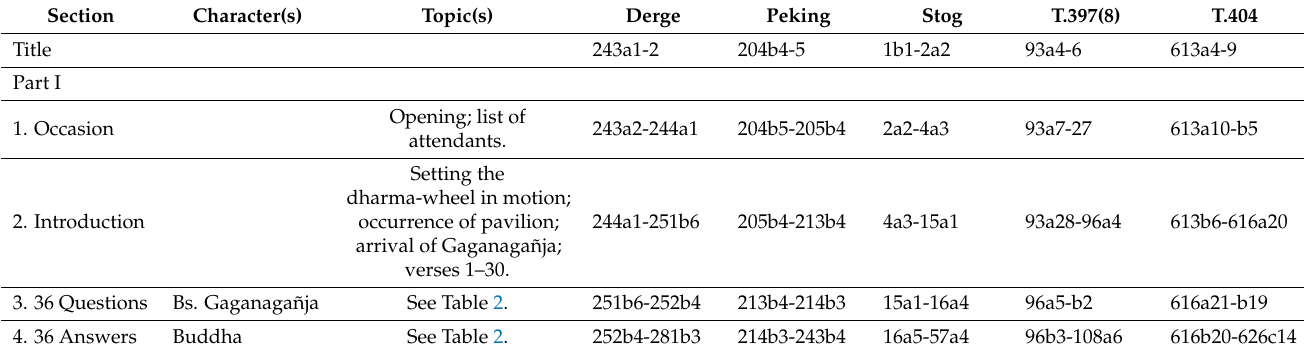
Table 1. Synoptic outline of the contents of